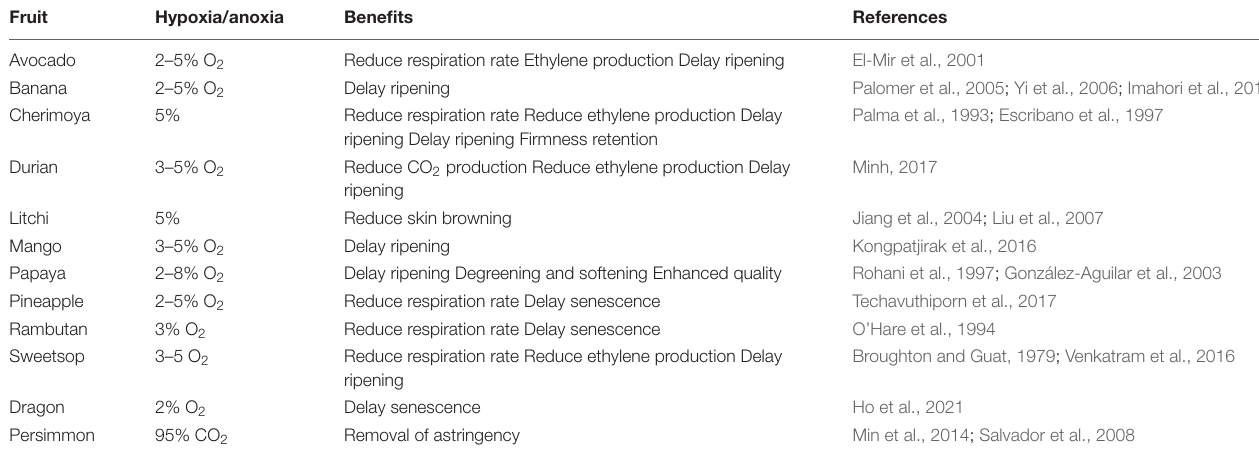
TABLE 1 | Effects of hypoxia/anoxia on some tropical fruits. Fruit Hypoxia/anoxia Benefits